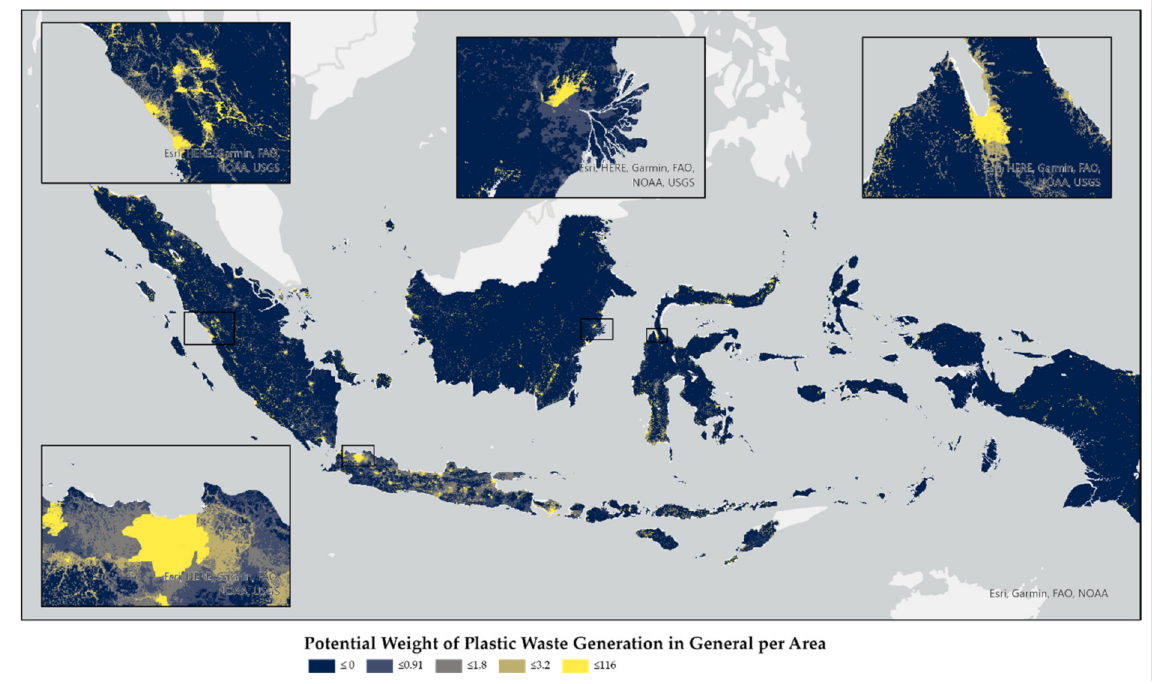
Figure 6. The potential weight per area of plastic waste generation in